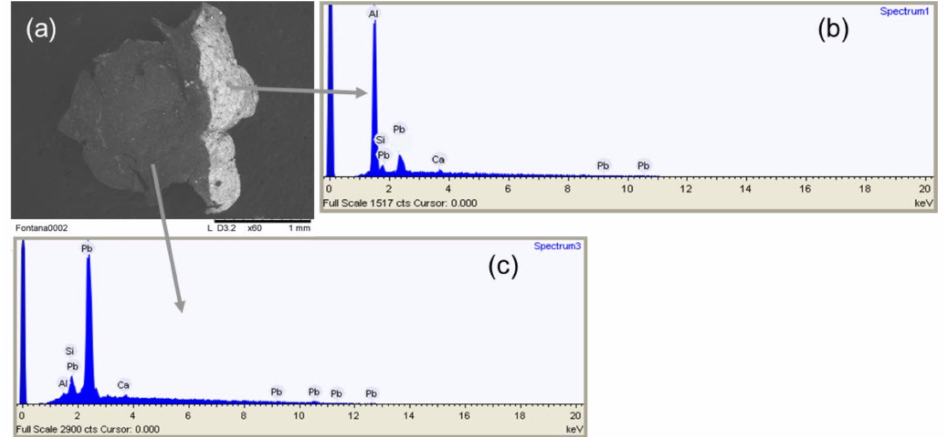
Figure 4. ( a ) SEM image of the sample taken from the silver dripping near the cut on the back of the “Concetto spaziale”; ( b ) EDX spectrum of the sample area with the highest mean Z value, corresponding to the silver paint; ( c ) EDX spectrum of the sample area with the lowest mean Z value, corresponding to preparation layer of the canvas.